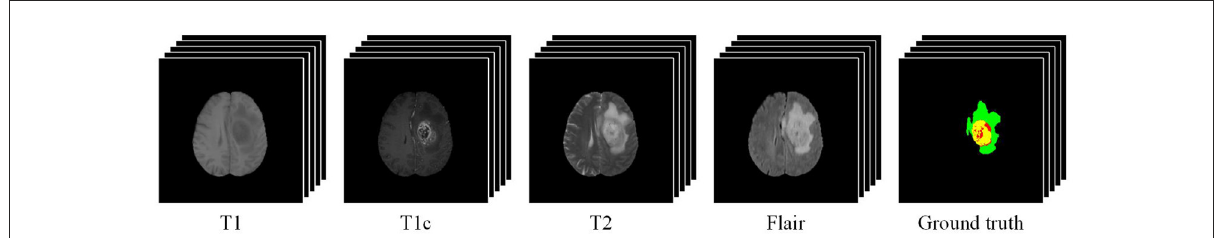
FIGURE1 An example of multimodal MRI volumes for brain tumor segmentation. The green, red, and yellow regions in the ground truth indicate edema (ED), non-enhancing tumor and necrosis (NCR/NET), and enhancing tumor (ET),